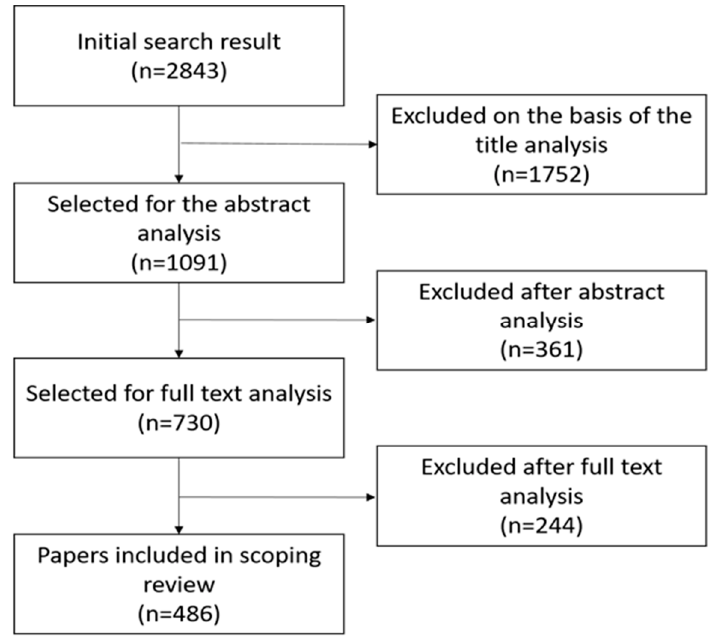
Figure 1. Scoping review search strategy.